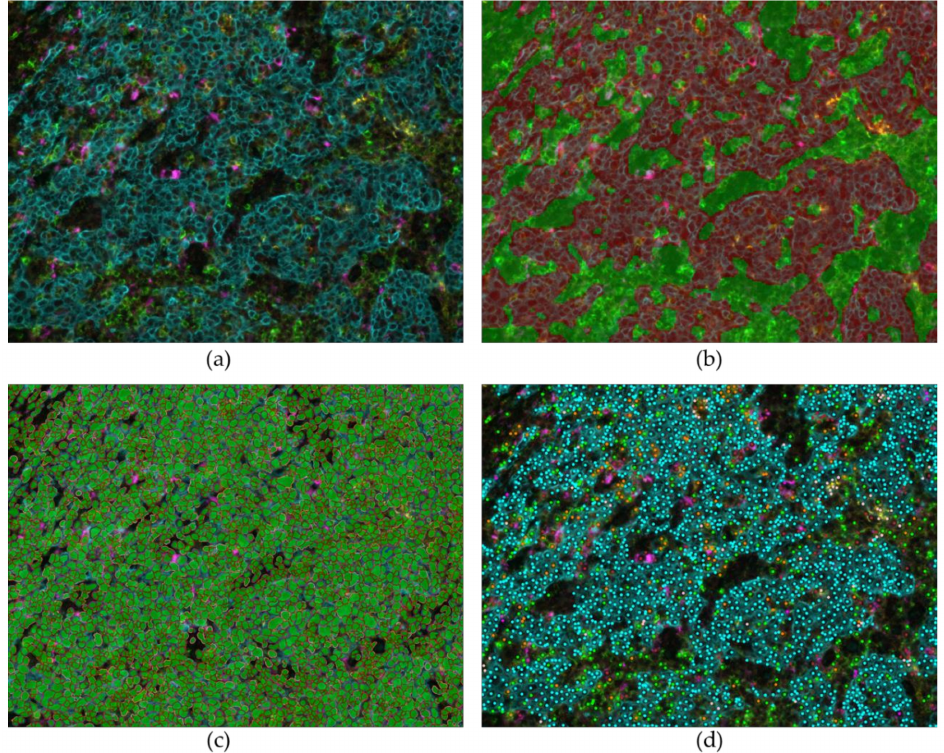
Figure 8. Automated digital analysis of fluorescent multiplexing using Inform software in tonsil tissue (20 × magnification). ( a ) Multiparametric fluorescent staining Pan-Cytokeratin (turquoise), CD4 (green), CD68 (purple), PD-1 (red), PD-L1 (yellow) and dapi (blue). ( b ) Tissue segmentation: identification and recognition of tumor areas (red) or stroma (green). ( c ) Individual cells identification and segmentation, with nuclear, membranous and cytoplasmic segmentation. ( d ) Phenotyping: identification of the cells on the slide, with their phenotypes, among all the cells present in the image, or among the cells